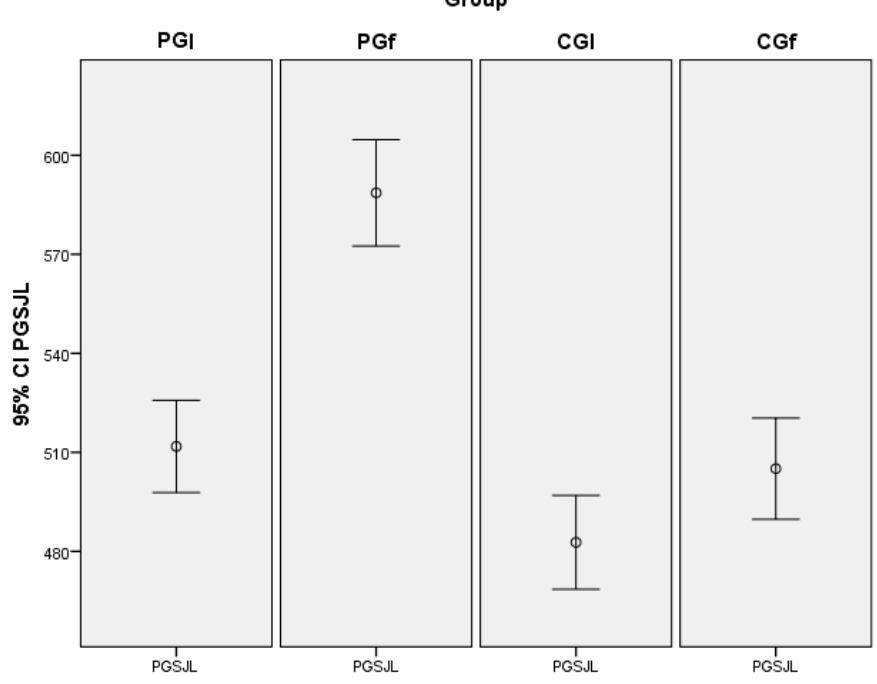
Figure 5. Standing triple jump means between the PG and CG group.